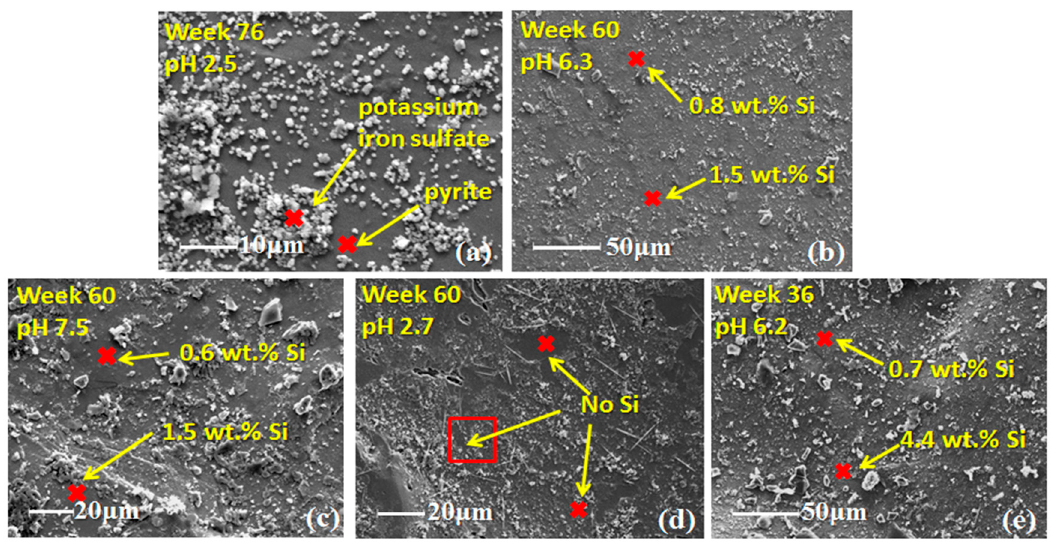
Figure 3. Secondary electron SEM images of samples collected from the four KLC tests containing synthetic waste. ( a ) Milli-Q; ( b ) Milli-Q with lime-saturated water; ( c ) calcite-saturated and lime-saturated water; ( d , e ) calcite-saturated water. Red crosses and the square in the images indicate EDS analysis areas. The potassium iron sulphate found on pyrite surfaces in (a) is likely to be potassium jarosite. The sample in (a) was collected immediately after the termination of the KLC experiment (i.e., at week 76). NB. The Si (silicate) is most likely derived from the dissolution of K-feldspar and/or chlorite.